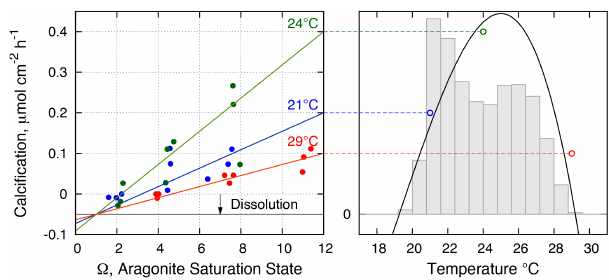
Figure 9. Left panel: calcification rate for Acropora eurystoma as a function of aragonite saturation state and temperature from Erez (2011). Right panel: histogram of daily SST for the Gulf of Aqaba from the NOAA pathfinder product (grey